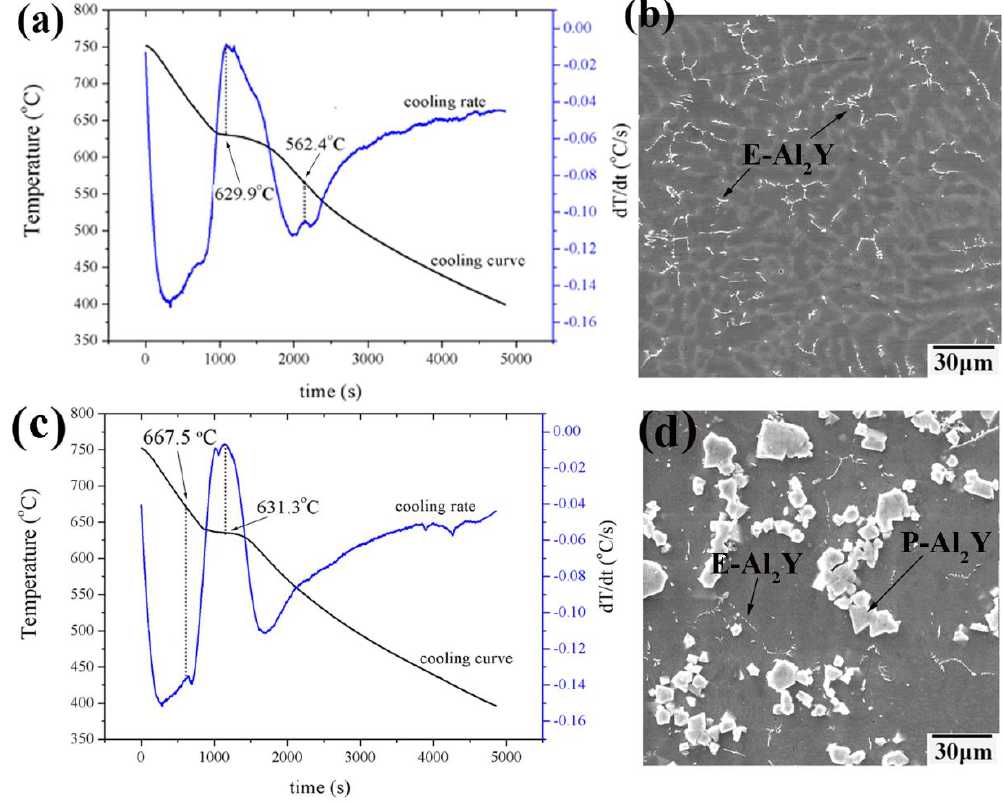
Figure 4. Thermal analysis results and solidification microstructures of Mg-6Y- x Al alloys: ( a , b ) YA605; ( c , d ) YA65. Table 2. The EDS results of solution yttrium from the Mg-6Y- x Al matrix in Figure 1.